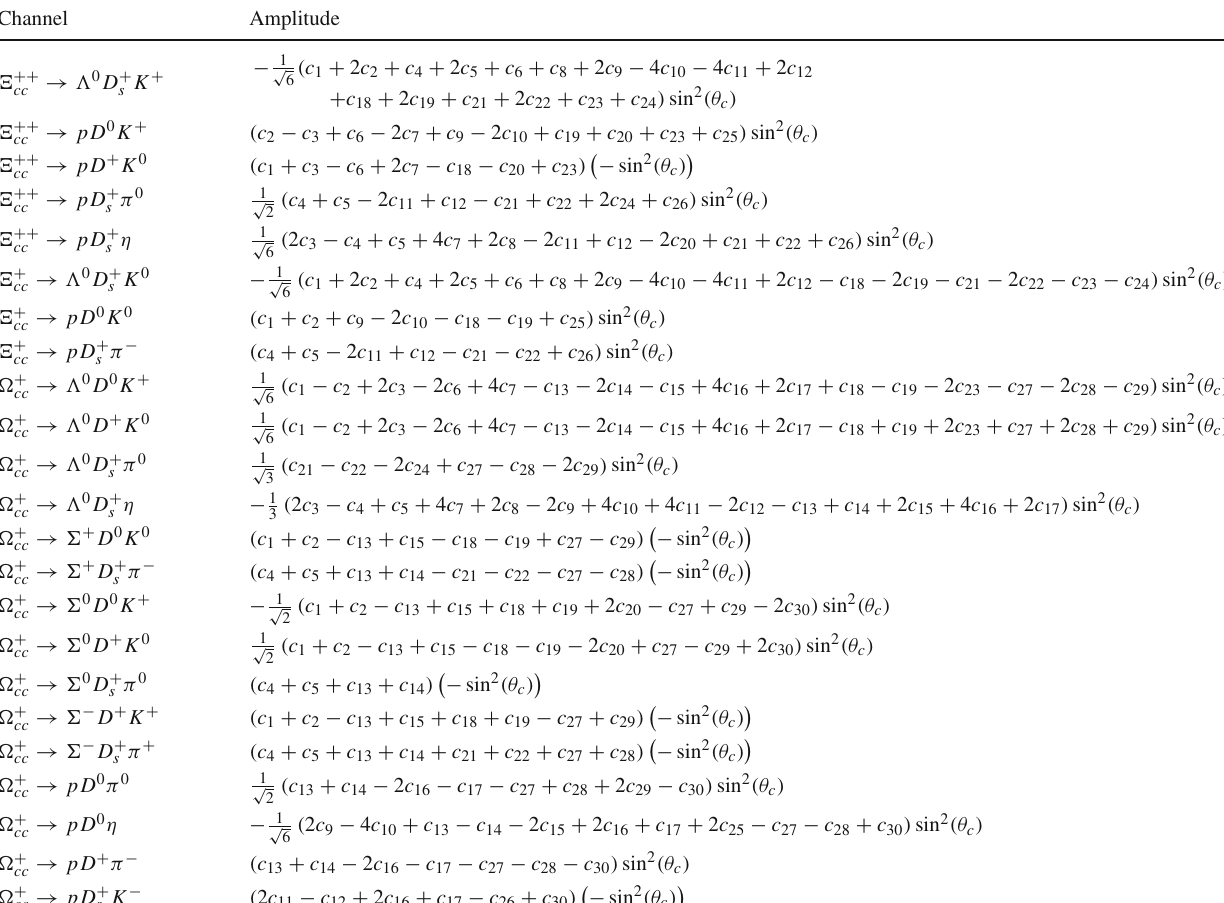
Table 13 Doubly charmed baryon decays into a light baryon in the octet, a charmed meson and a light meson Channel